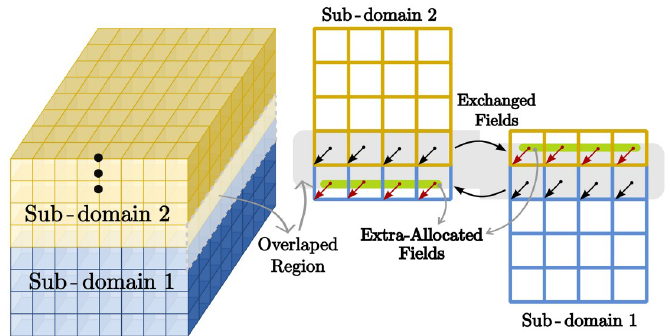
Fig 2. The computational domain is divided into sub-domains according to the number of available computer units. The H-fields in the overlapped region is exchanged between neighbour sub-domains.